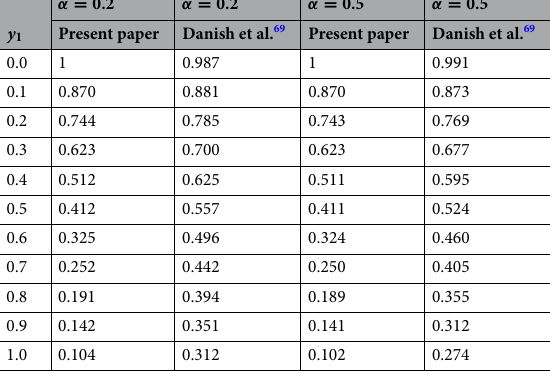
Table 4. Effect of fractional parameter on dimensionless velocity.